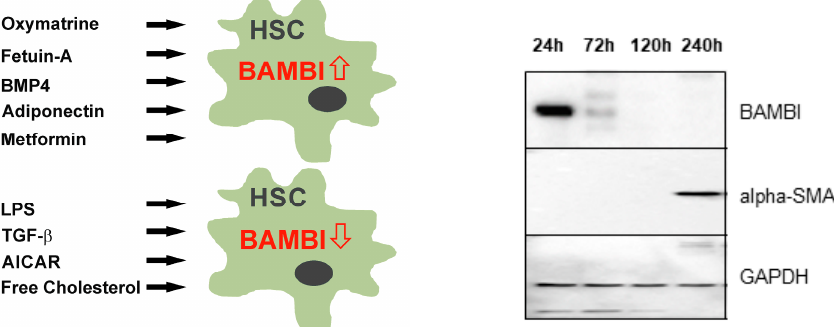
Figure 4. Substances regulating BAMBI expression in hepatic stellate cells (HSCs) and BAMBI expression during primary human HSC cultivation. The immunoblot shows BAMBI protein and alpha-SMA in HSCs cultivated for 24 h, 72 h, 120 h, and 240 h on plastic dishes. GAPDH is shown as loading control. 5-Aminoimidazole-4-carboxamide ribonucleotide, AICAR; bone morphogenetic protein 4, BMP4; Glycerinaldehyd-3-Phosphate-Dehydrogenase, GAPDH; Lipopolysaccharide, LPS; Transforming growth factor- β , TGF- β .